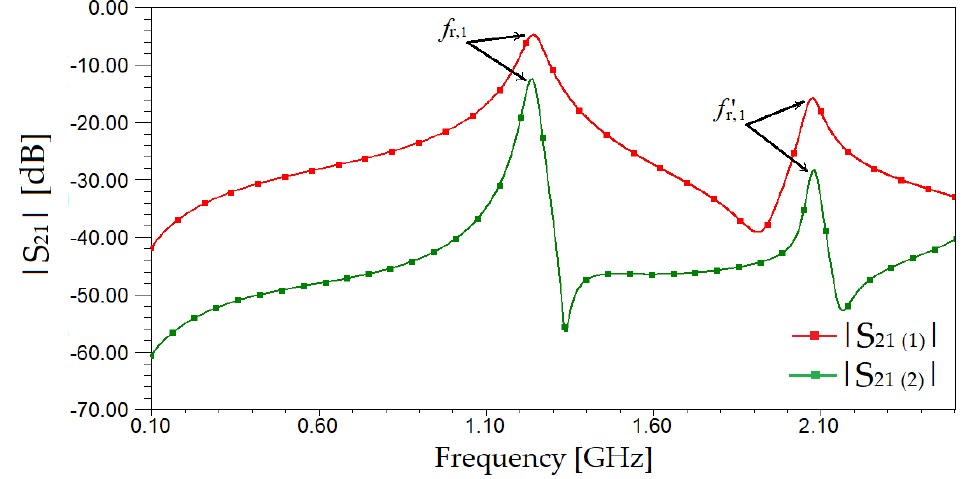
Figure 3. Scattering parameters for sensors made of one modified SRR-S 21(1) and two modified SRRs-S 21(2) .